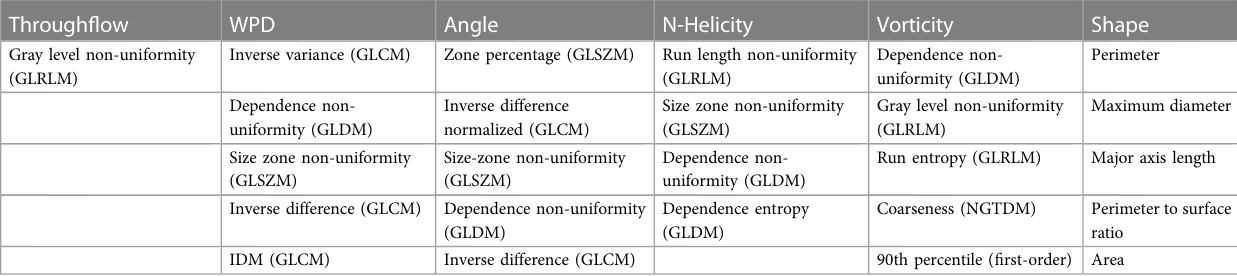
TABLE 5 Inter-scanner agreement (ICC) of all features grouped by type of feature map and contour shape feature type. The best features per parameter map with moderate agreement are listed in the